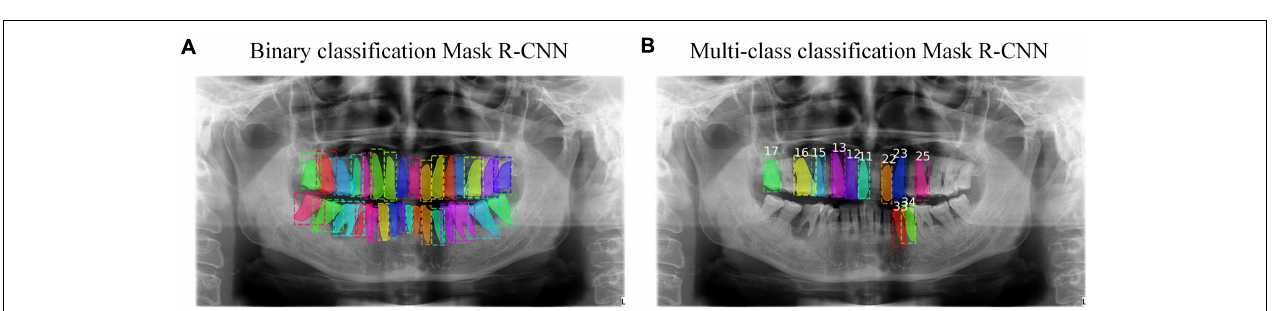
FIGURE 3 | (A) The result of binary classification Mask R-CNN. (B) The result of multi-class classification Mask R-CNN. Each color in these two results represents different